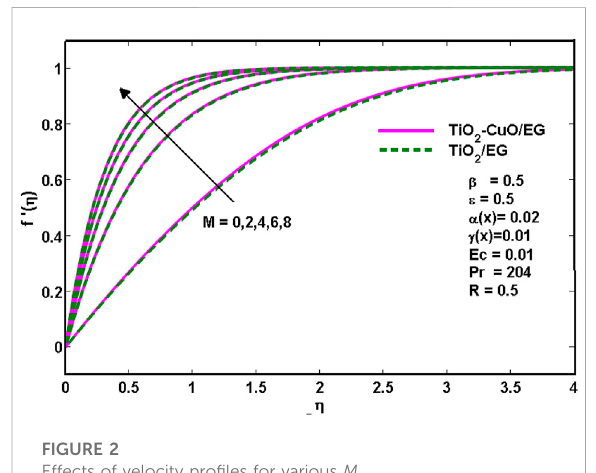
FIGURE 2 Effects of velocity pro fi les for various M .